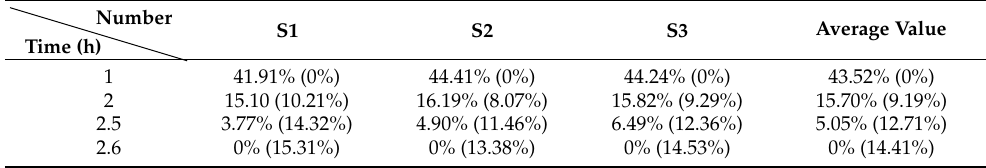
Table 2. The relationship between the time and fissure rate of S1, S2 and S3 of soil samples with particle size of 1mm.